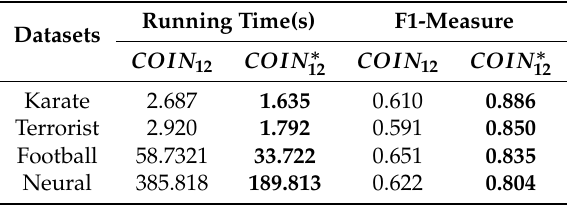
Table 4. The running time and F1-score of COIN 12 and COIN ∗ on the experimental datasets. 12